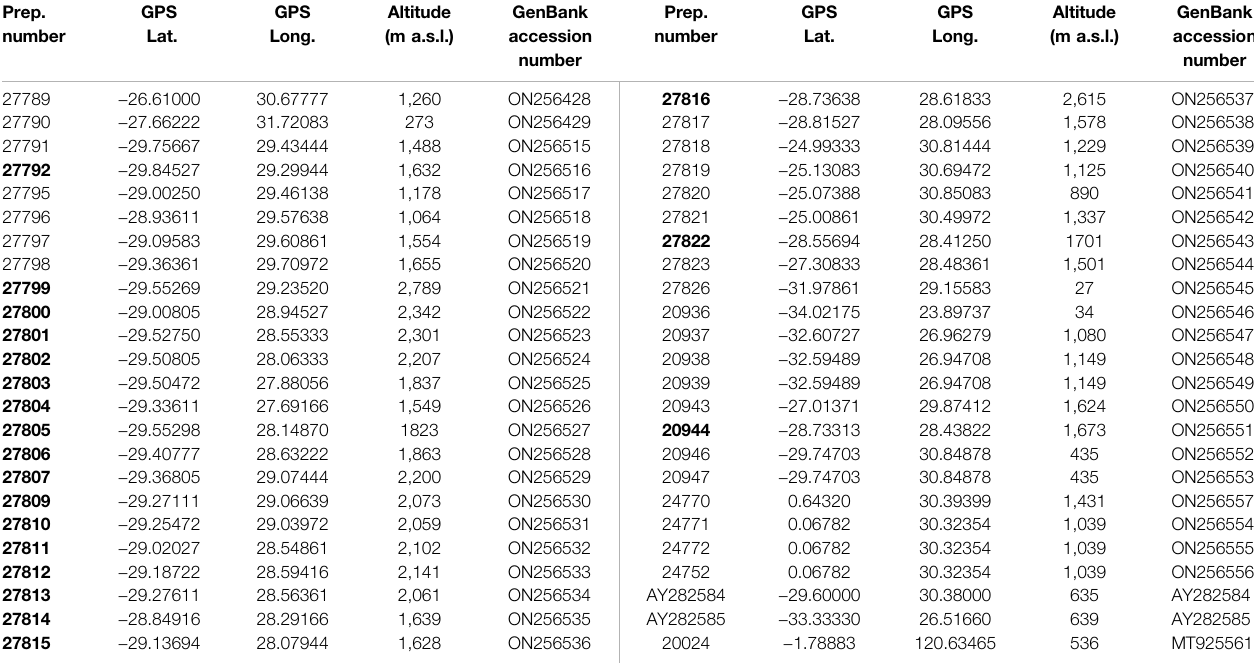
TABLE 1 | Preparation numbers, GPS coordinates (Longitude and Latitude), altitude and GenBank accession numbers of all Burnupia specimens used in the current study and the Protancylus outgroup (Prep. number: 20024). Prep. GPS GPS number Lat.